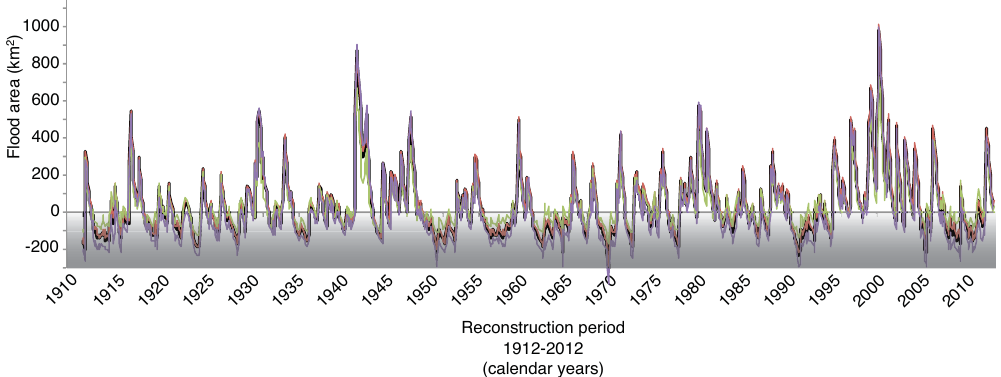
Figure A2. Observed against reconstructed monthly (cid:49)F A values ( n = 160) for the 1988–2012 calibration period ( R 2 value < 0.001).